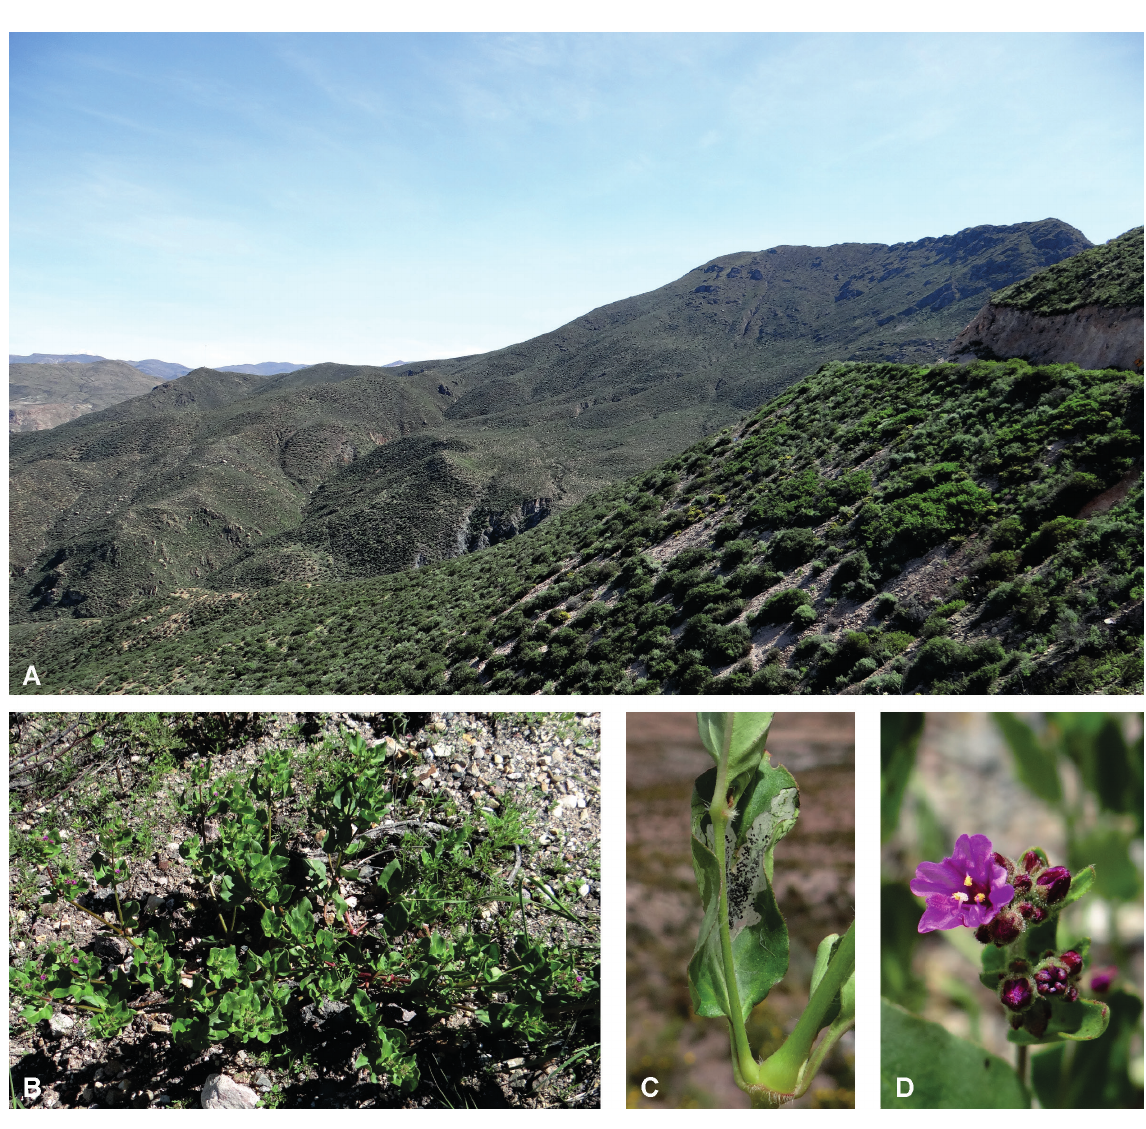
Fig. 7. Habitat and host plant of Helioandesia tarregai gen. et sp. nov. A . The type locality near Zapahuira Village at about 3400 m elevation on the western slopes of the Andes of the Parinacota Province, northern Chile. B . The host plant Mirabilis acuta (Reiche) Heimerl (Nyctaginaceae). C . Detail of the damage pattern on a leaf of the host. D . Flower of M. acuta